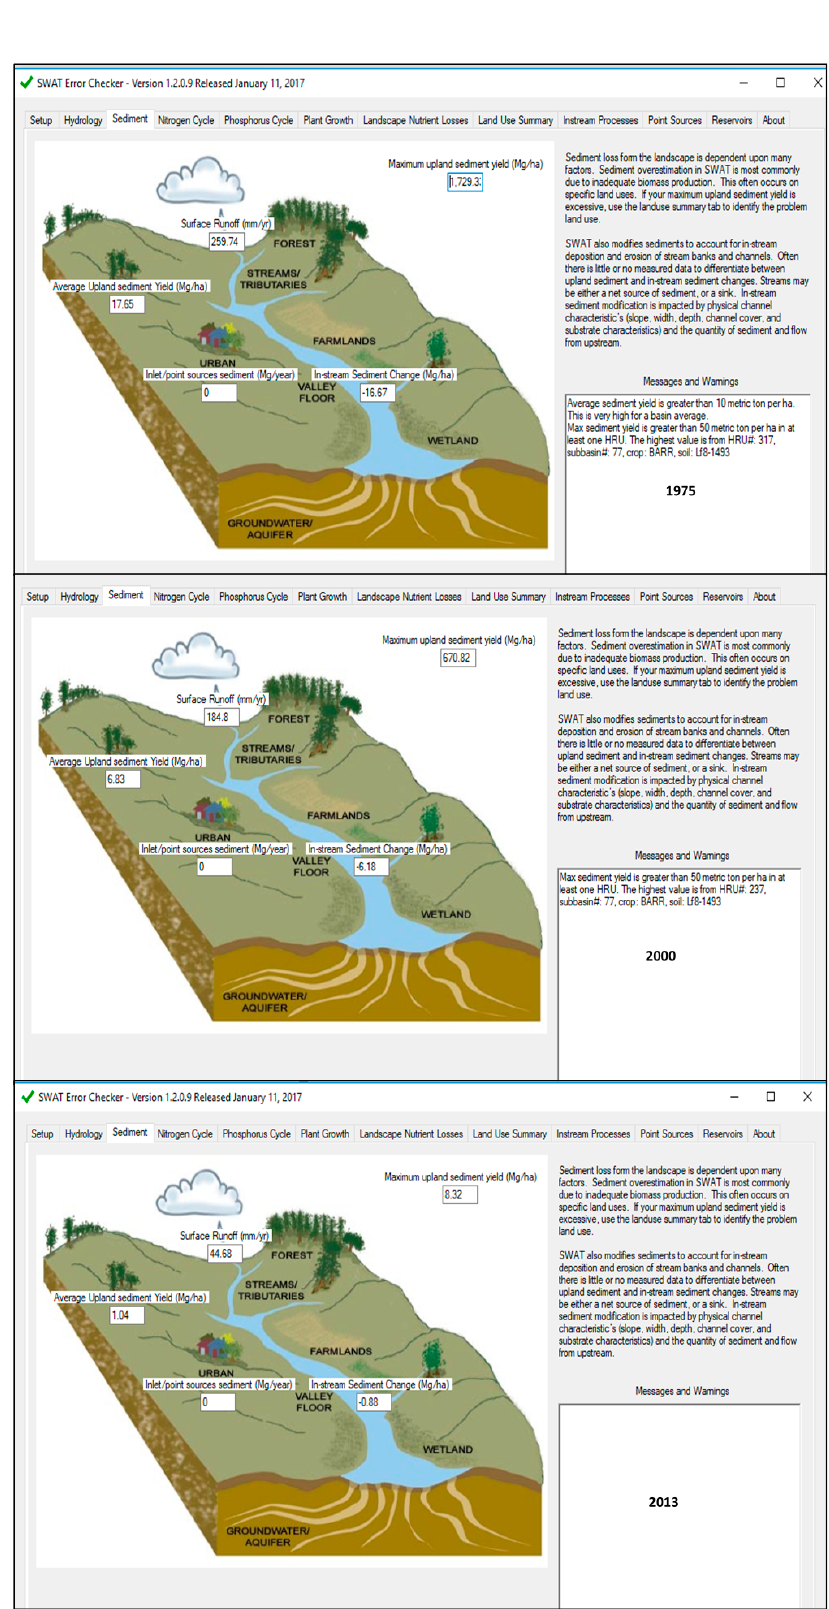
Figure 5. Simulated sediment yield models for the Kaduna Watershed between 1975 and 2013. Note the consistent reduction in the upland sediment yield values from 1975 to 2013.